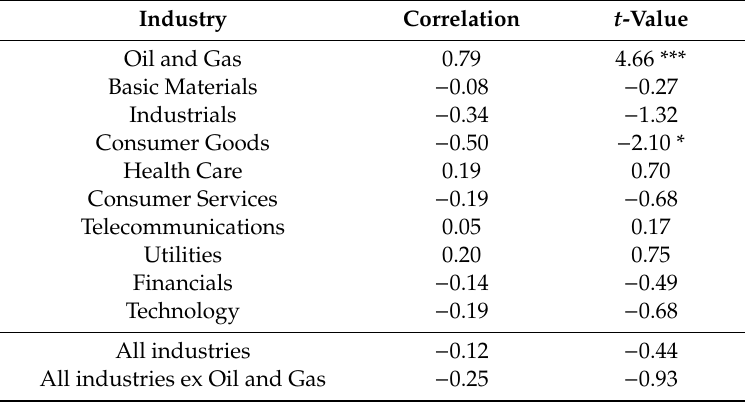
Table 8. Correlations between the GPFG-industry weighted operating cash flow of each industry and the GPCF. All correlations on first-di ff erence data